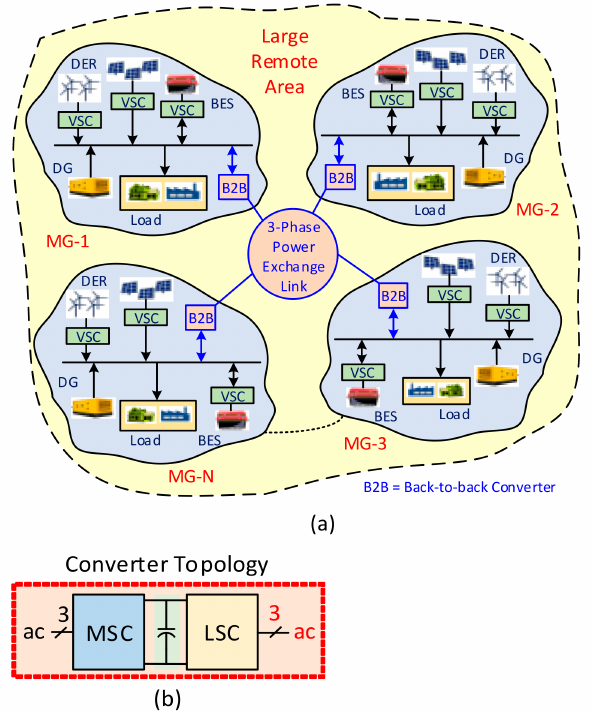
Figure 1. Schematic of CMG networks, ( a ) MG structure and their interconnection with the power exchange link, ( b ) back-to-back three-phase converter